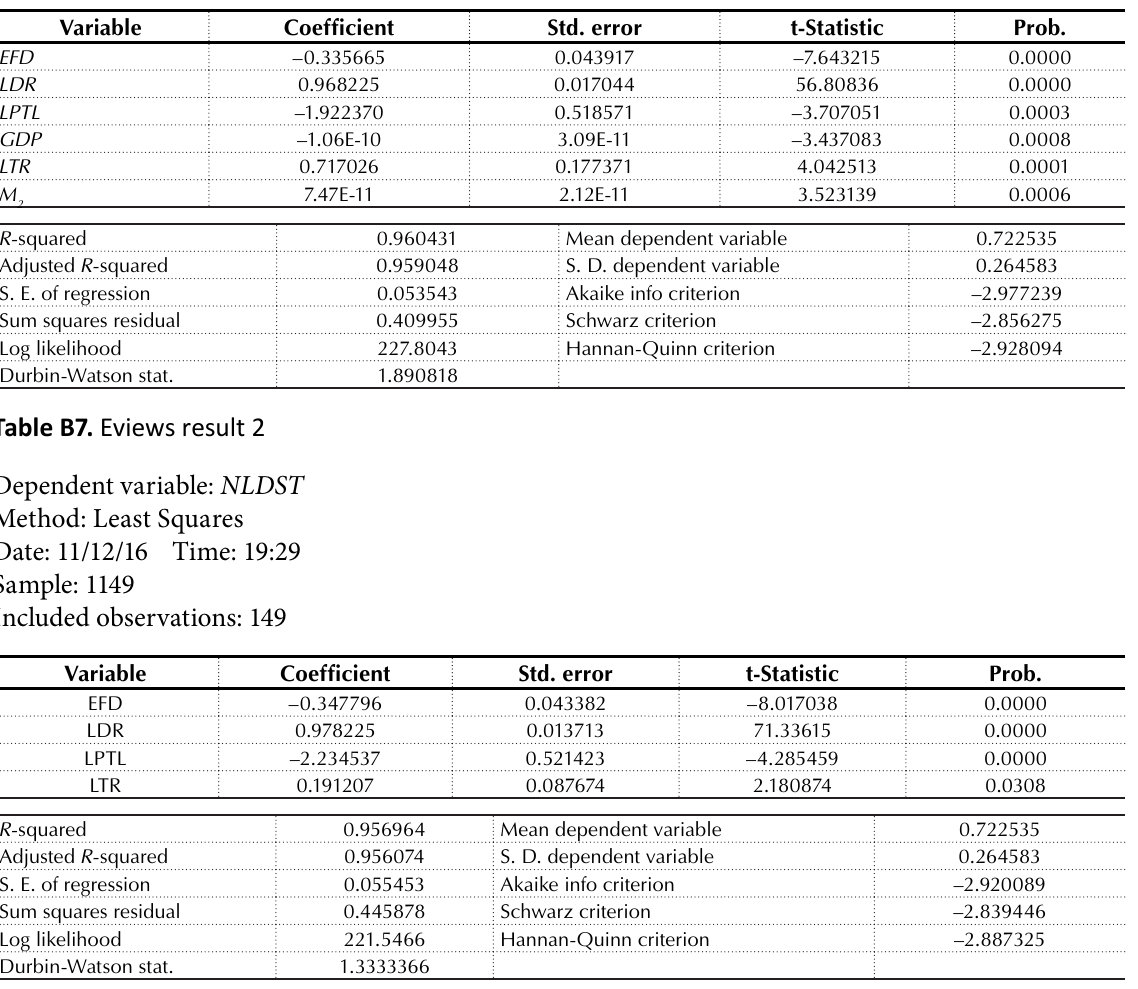
Table B6. EViews result